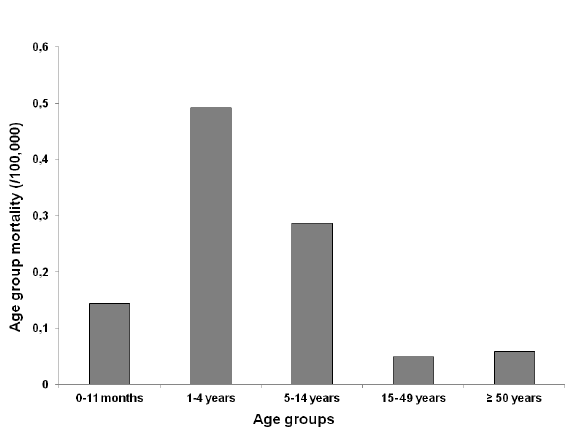
Figure 5. Incidence of scorpion stings according to anatomical site.